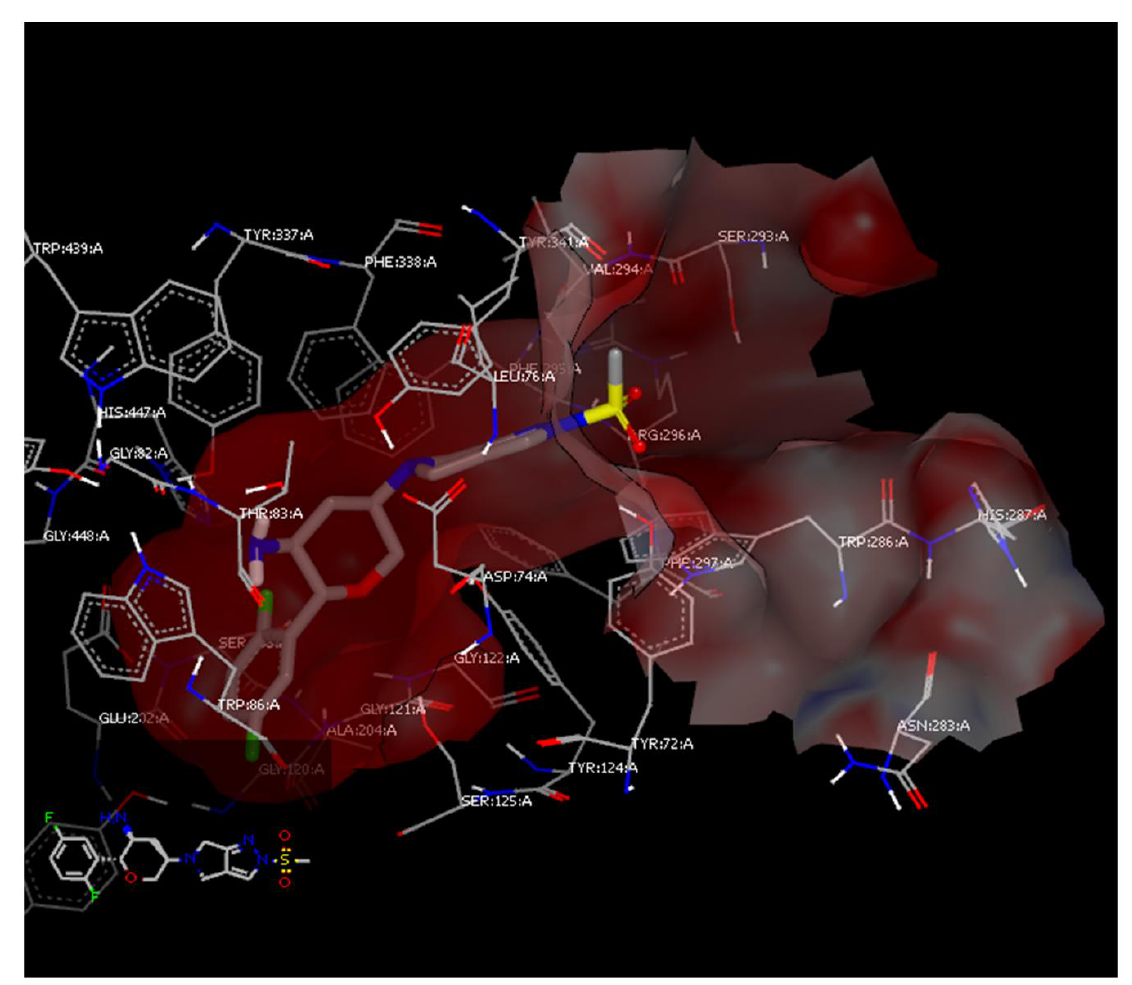
Figure 3. Predicted binding mode of OMR with AChE crystal